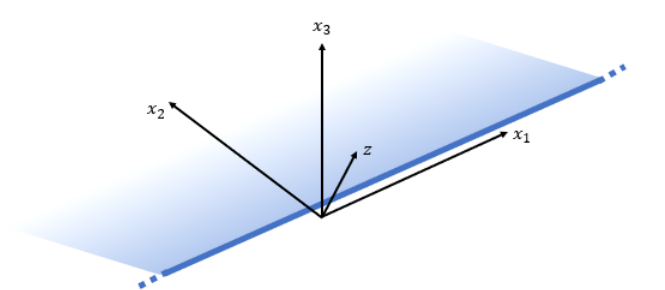
Figure 4 . D6-brane dual to the semi-infinite sheet. It is taken to be extended along the x 1 axis and along the positive values of the x axis. The directions x and z are orthogonal to the sheet. 2 3 Every point is also extended in time and along other four dimensions which are wrapped on S 4